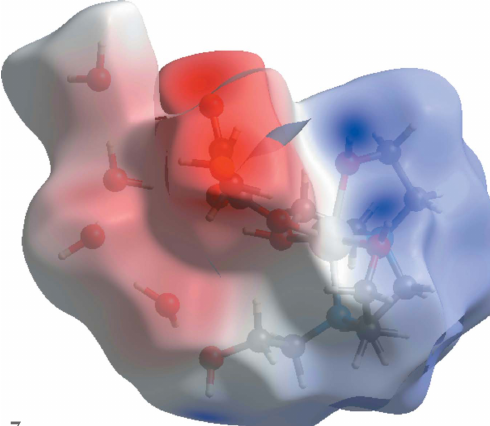
Figure 7 Hirshfeld surface plotted over electrostatic potential